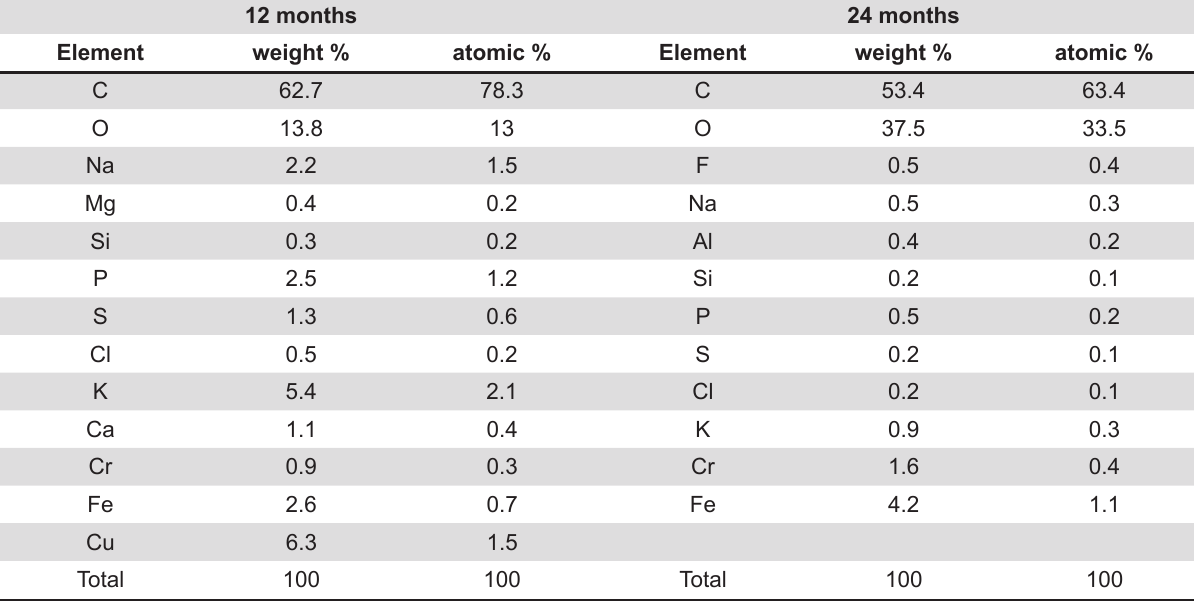
Figure 5- Biofilm deposit over the bracket slot after exposure to the intraoral medium for 12 (A) and 24 (B) months; 150x Table 3- EDS semi-quantitative chemical analysis on the deposits found in an orthodontic bracket slot used for 12 or 24 months